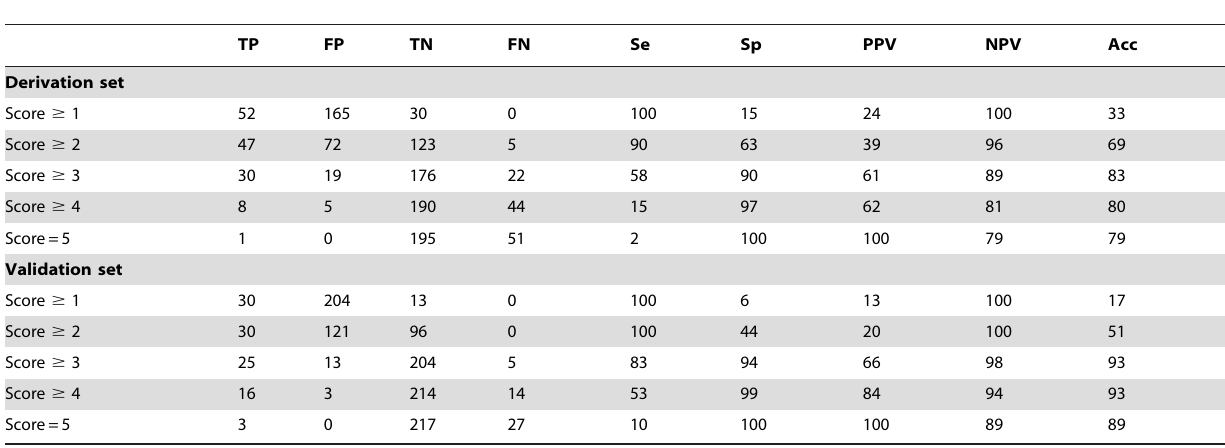
Table 5. Model and risk score performance: derivation set (n =247) and validation set